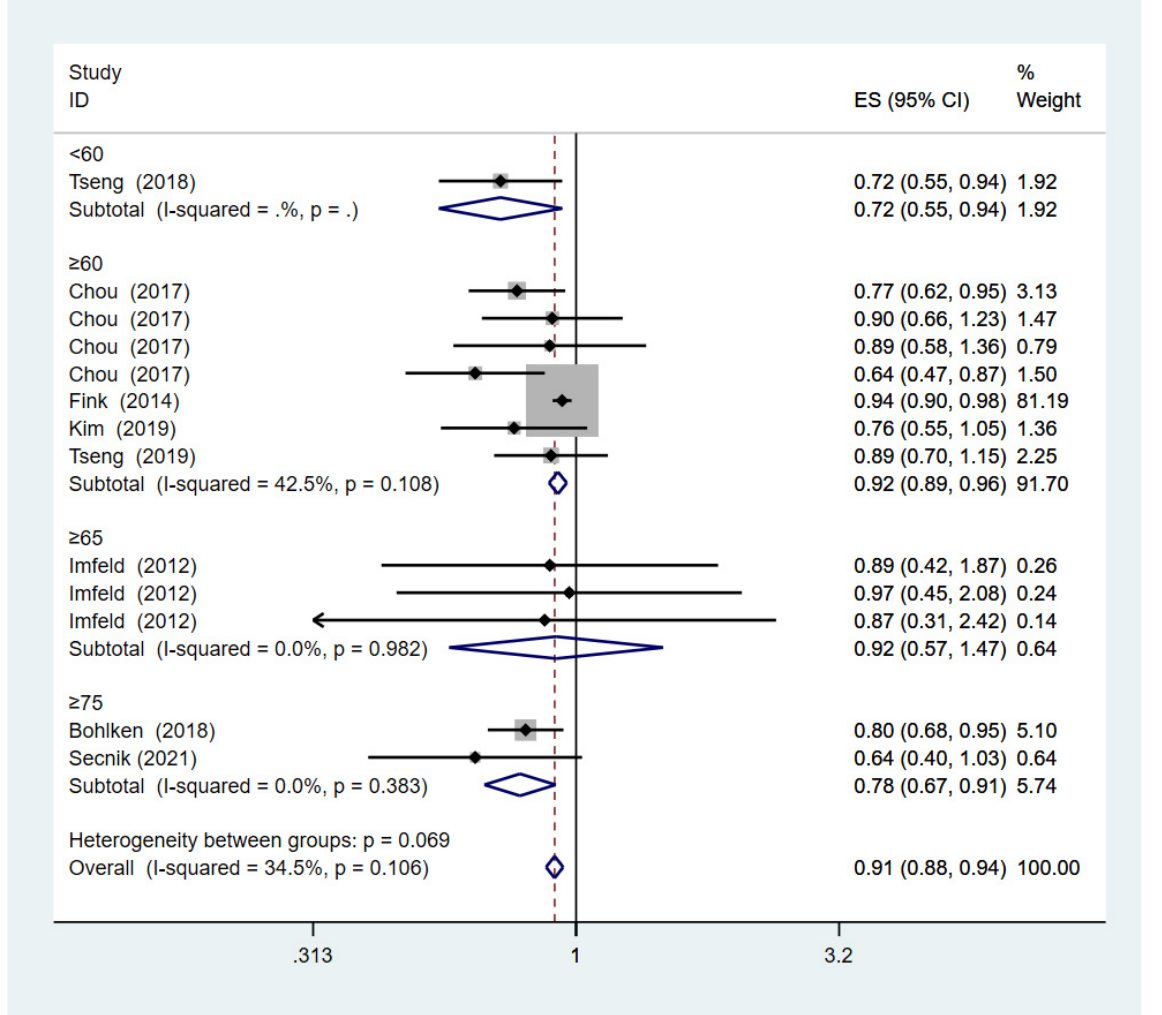
Figure 3. Dementia risk under PPAR ‐γ agonist treatment in DM patients (sub ‐ group: age).